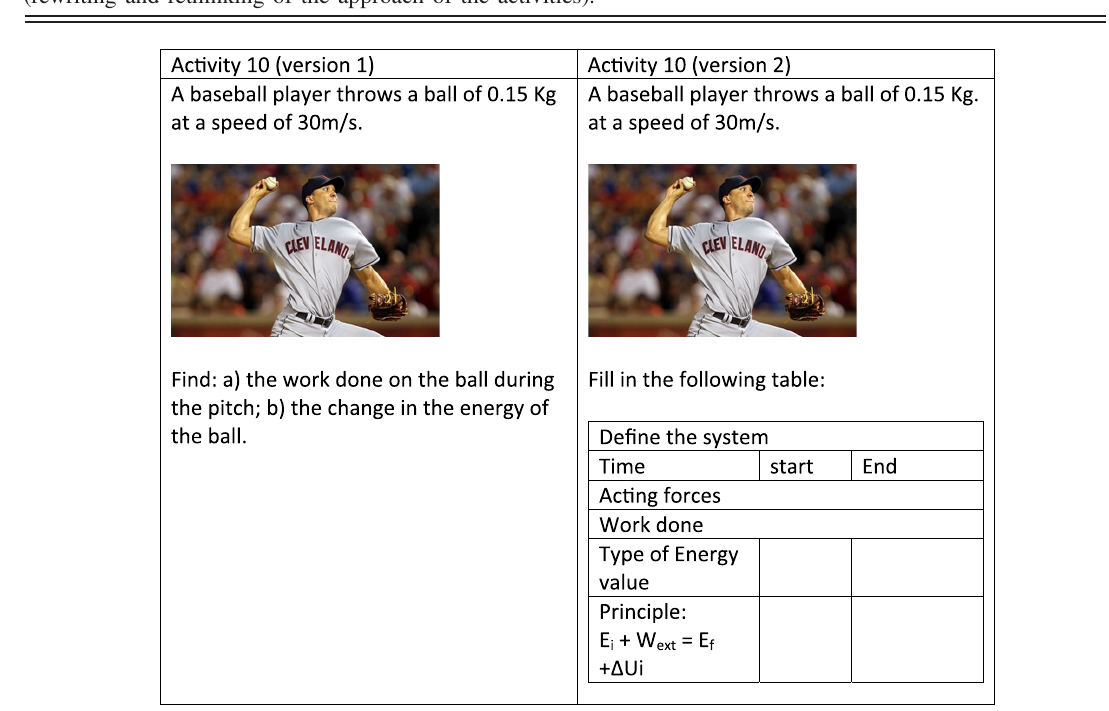
TABLE V. Students ’ metacognitive difficulties encountered when implementing the TLS and its redesign (rewriting and rethinking of the approach of the